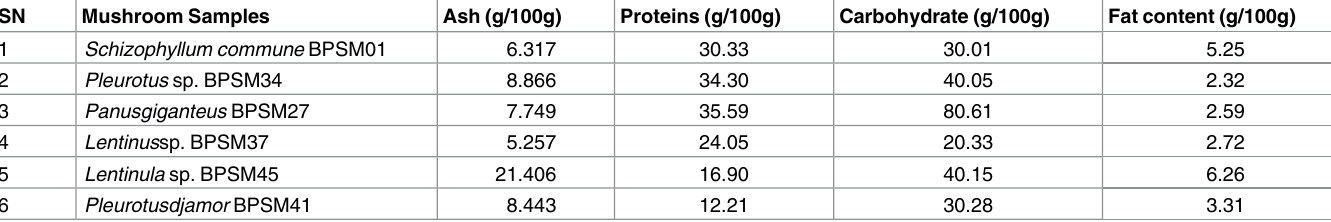
Table 5. Determination of Ash, Protein, Carbohydrate and Fat content in selected wild mushrooms. SN Mushroom Samples Ash